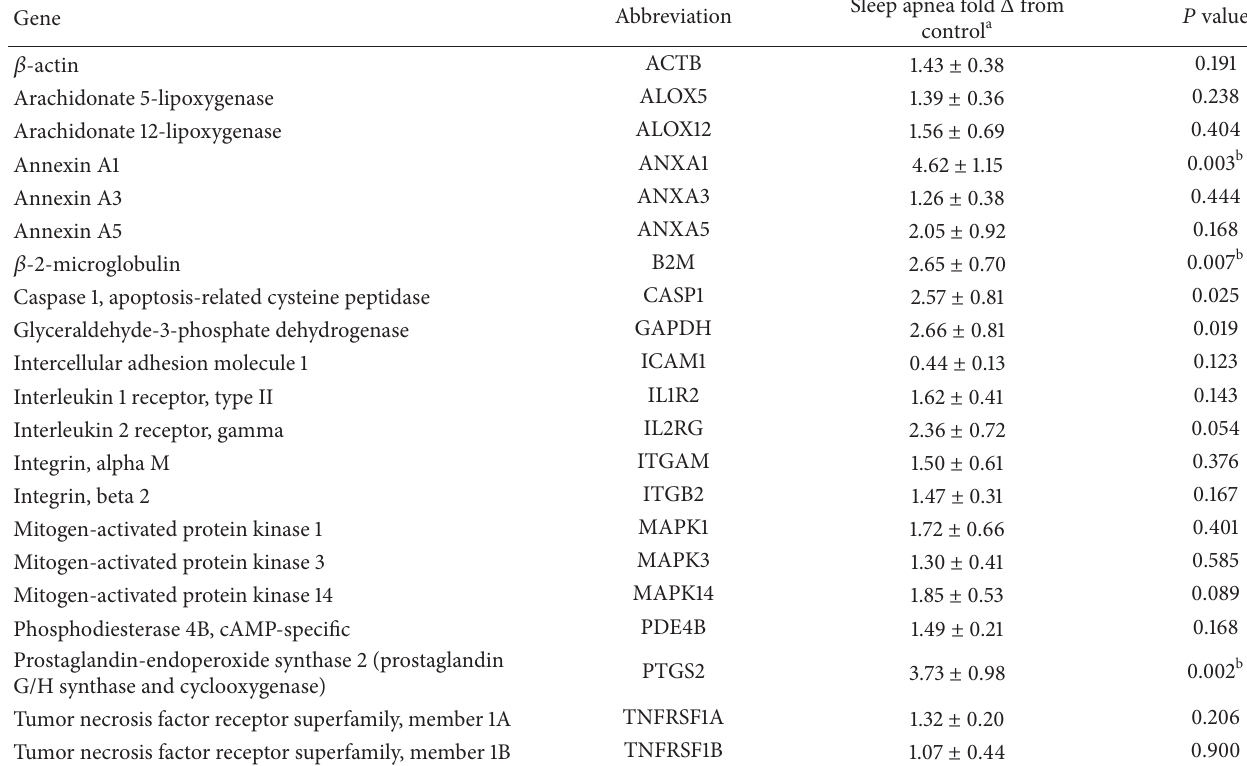
Table 2: Salivary transcript levels in patients with sleep apnea compared to controls.